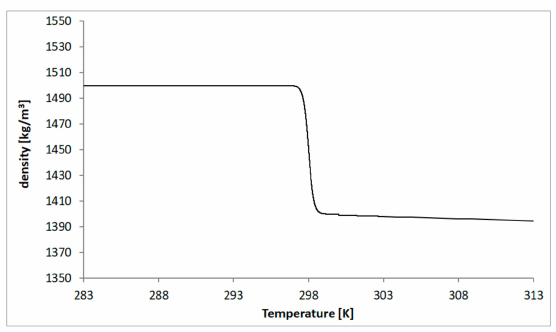
Figure 2. Density of used phase change materials (PCM).